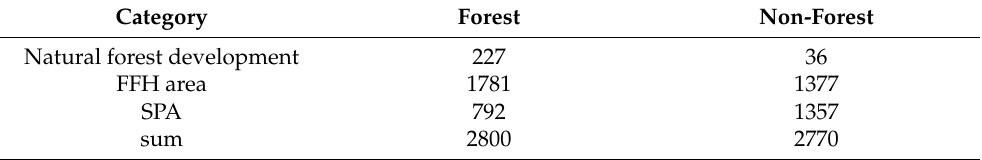
Table A2. Protected Areas in Forests and non-forest Land Use Types in 1000 ha (Source: NW-FVA [35]). Category Forest